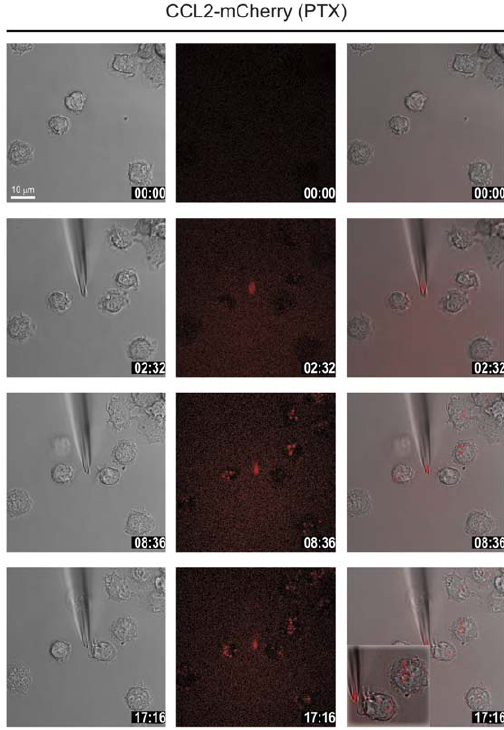
Figure 7. Pertussis toxin does not inhibit CCL2 uptake. Selected frames from time-lapse video microscopy (Movie S8) of migrating human monocytes recorded at 37 u C. Monocytes were pretreated with 2 m g/ml Bordetella Pertussis toxin (PTX) for 2 h. The micropipette was dispending 100 nM CCL2-mCherry with constant backpressure. Left panels phase images, middle panels CCL2-mCherry (ex 594 nm/em 620–680 nm), and right overlay. Inset of bottom right panel, zoomed presentation of the same cells showing randomly localized internalized CCL2-mCherry. Time stamps are indicated in mm:ss.